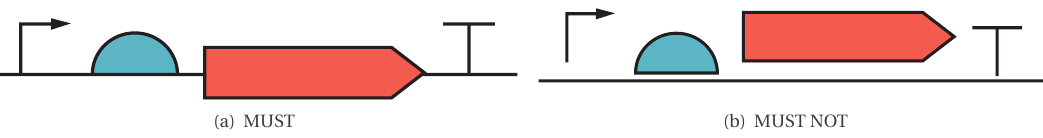
Figure 9: Examples of correct and incorrect association of glyphs with a nucleic acid backbone.